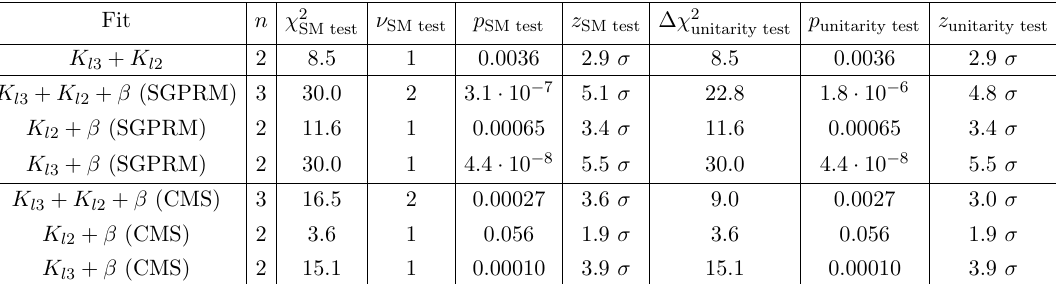
Table 3 . Cabibbo angle universality SM test and CKM unitarity tests for di(cid:11)erent data sets. z SM test is the signi(cid:12)cance of the rejection of Cabibbo angle universality and z unitarity test is the signi(cid:12)cance of the CKM unitarity